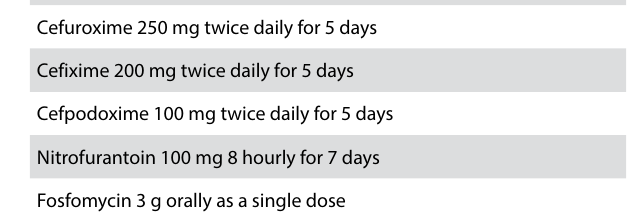
Table III: Ampath’s recommendations for the oral treatment of acute uncomplicated cystitis, based on current susceptibility patterns for E-Coli